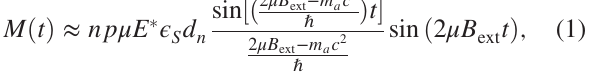
(cid:1) is perpendicular to ~B . The ext